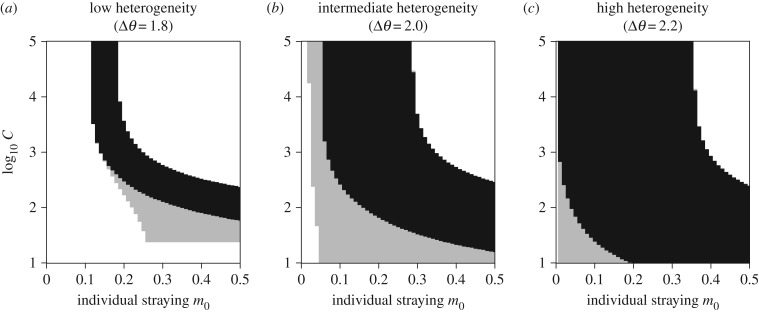
Alternative stable state regimes I (grey) and II (black) as a function of individual straying m0 and the strength of collective behaviour C (note the log10 scale). Regime I signifies parameter space where there is either (1) an intermediate-density, symmetric steady state, or (2) an asymmetric dominant/subordinate density. Regime II signifies parameter space where there is an asymmetric dominant/subordinate steady-state density. The white space to the left (lower values of m0) signifies high-density, symmetric steady states, and the white space to the right (higher values of m0) signifies low-density, symmetric, steady states. Relationships are shown for (a) low habitat heterogeneity (Δθ), (b) intermediate habitat heterogeneity and (c) high heterogeneity. The horizontal cut-off of Region I at low values of C in (a) is due to numerical limitations.